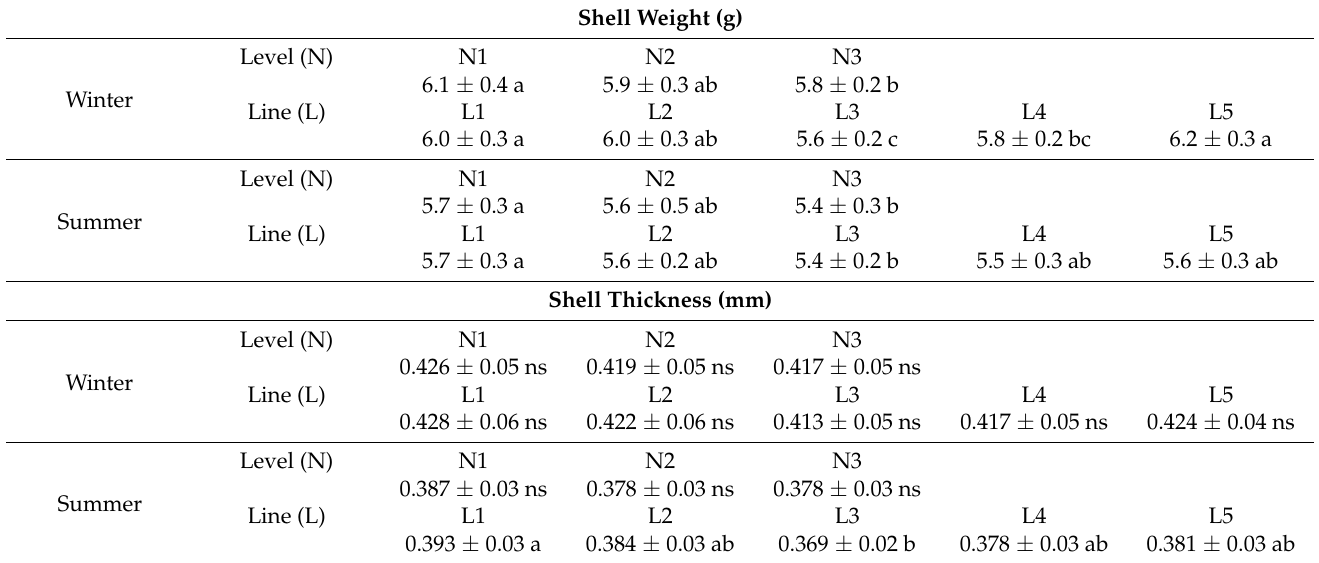
Table 6. Comparison between mean shell weight (g) and shell thickness (mm) obtained in the aviaries in winter and summer for the factors level (N) and line